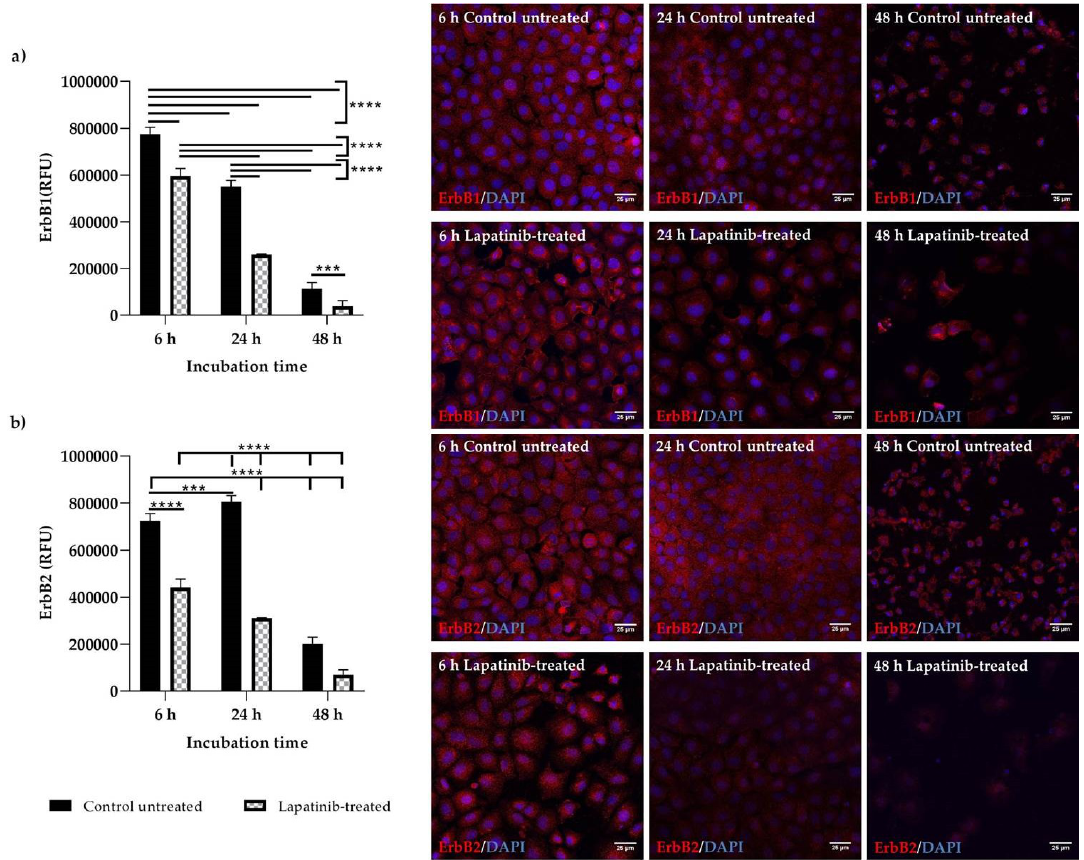
Figure 5. Immunofluorescence staining of ErbB1 and ErbB2 in control untreated and lapatinib-treated IEC-6 rat normal small intestinal epithelial cells at 6, 24 and 48 h incubation. Images shown are overlay images of ( a ) ErbB1 (red)/DAPI (blue) and ( b ) ErbB2 (red)/DAPi (blue). ErbB1 and ErbB2 proteins were expressed in IEC-6 at all time points but with different staining intensities. Corrected total cell fluorescence (CTCF) for ErbB1 and ErbB2 staining intensities were expressed as relative fluorescence units (RFU) as shown on the graphs. Data presented as mean ± S.E.M ( n = 6). Results were compared between control untreated and lapatinib-treated cells at different incubation h. Significant differences between groups are indicated by bars. *** for p < 0.001 and **** for p < 0.0001. The staining intensities of control untreated and lapatinib-treated cells were also compared with negative controls (1% BSA and Rabbit IgG) which were stained with secondary antibody only (red) (images not shown). Images are of x60 original magnification (Scale bar:25 μm).